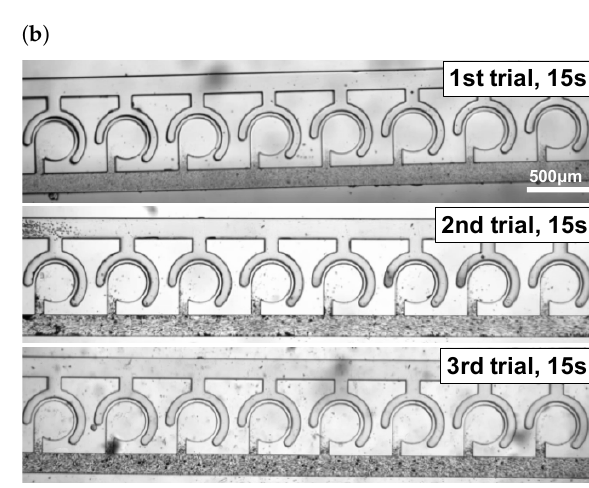
Figure A3. Use of pressure gradient. ( a ) Air was supplied from the left side of the figure, and the driving chamber was deformed by air pressure. The pressure gradient was generated by the pressure drop through the flow path, which generated the concentration gradient. ( b ) Experimental results of ( a ). Each chamber was driven for 15 s, but no stirring occurred.